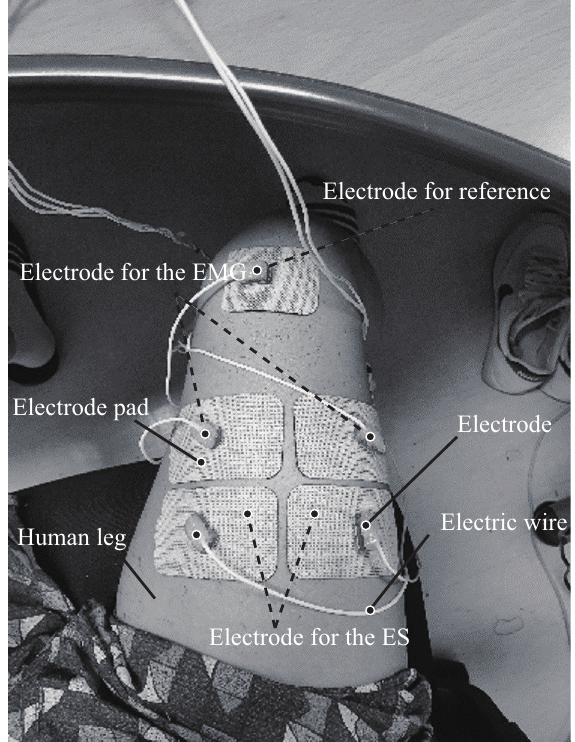
Figure 1. Outline of the IR data acquisition method.